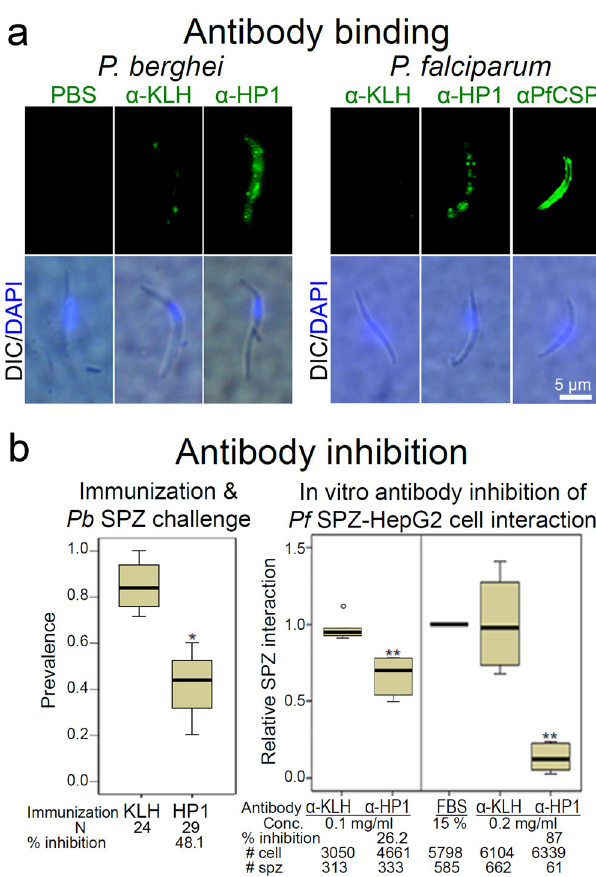
Fig. 3 An anti-HP1 peptide antibody binds to the Plasmodium sporozoite surface and inhibits sporozoite – hepatocyte interaction. a Binding of an anti-HP1 peptide antibody to non-permeabilized P. berghei and P. falciparum sporozoites was detected with Alexa488-conjugated secondary antibody. b left panel , Mice were immunized with KLH-conjugated HP1 peptide, and 10 days after the third boost, the mice were challenged by the bite of two infected mosquitoes. Immunization with KLH alone served as a control. The prevalence of mouse infection was determined by Giemsa staining of thin blood smears (* P = 0.02). Data pooled from four biological repeats. N : number of mice challenged. b right panel , P. falciparum sporozoites were pre-incubated for 10 min with sera from mice that were immunized with KLH-conjugated HP1 or with non-conjugated KLH, and then incubated with HepG2 human hepatoma cells for 1 h. ** P = 0.002 in the left and P = 0.004 in the right. Data pooled from two biological repeats. All box plots show quartiles, medians, minimum, and maximums within the bounds of 1.5 times the interquartile range. A dot represents an outlier beyond the upper bound. The % inhibition was calculated using medians. Relative sporozoite interaction was determined by normalizing sporozoite counts compared to the mean of the anti-KLH antibody-treated control group. Two tail P -value by Mann – Whitney U test. Source data are provided as a Source Data fi le.